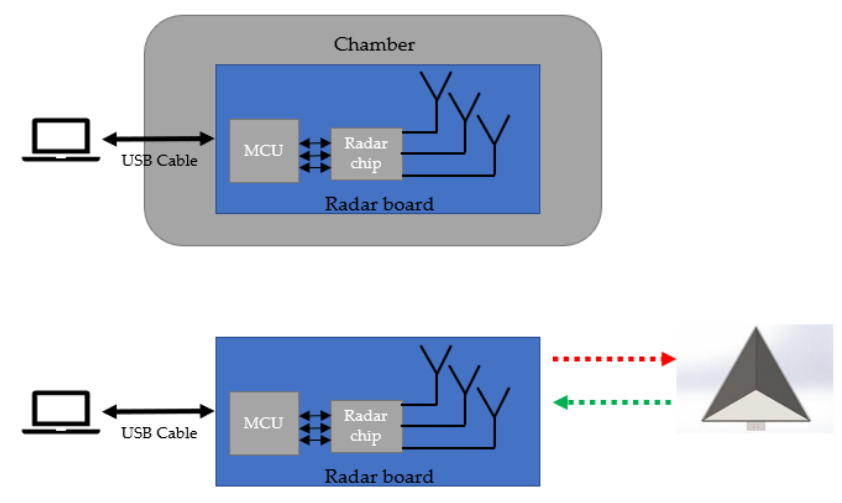
Figure 4. Three different isolation levels.